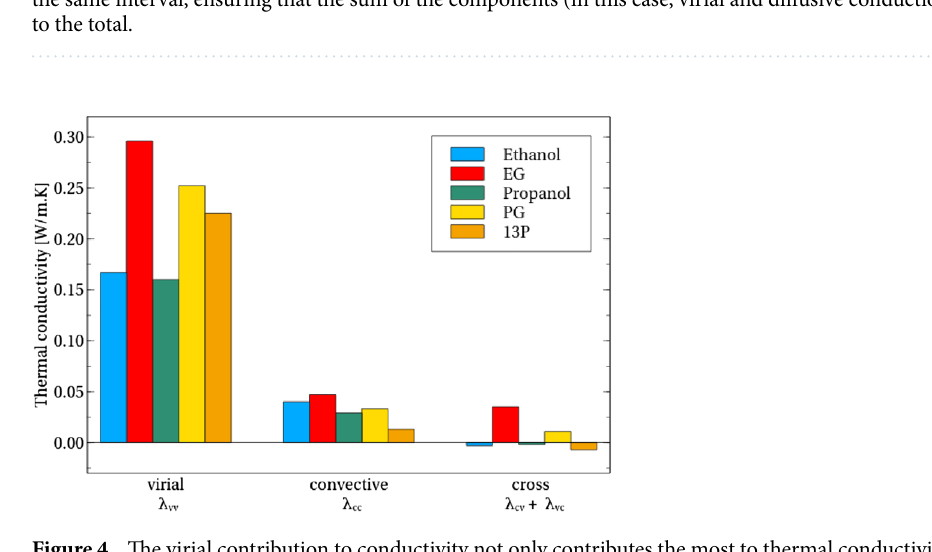
Figure 4. The virial contribution to conductivity not only contributes the most to thermal conductivity for each molecule, but is also the driving contribution behind much variation between the